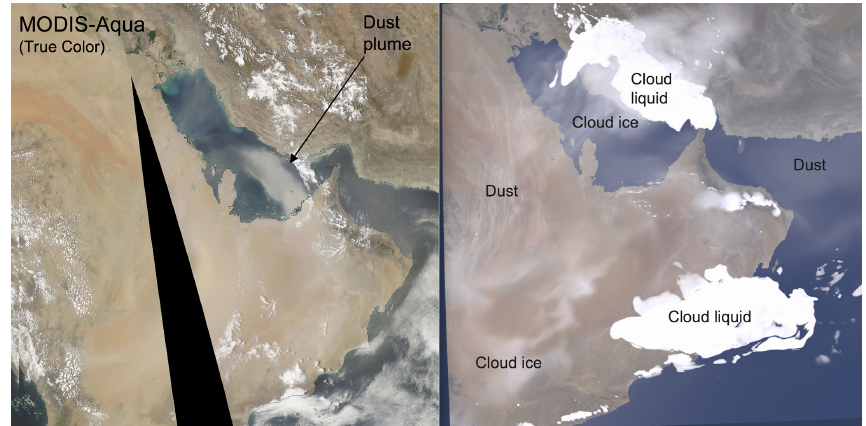
Figure 13. MODIS-Aqua image (left) taken from passes at about 13:30 mean solar time over the Arabian Peninsula compared with SWIm visualization of a RAMS model forecast (right) from 10:00UTC. Areas having predominantly dust, cloud liquid, and cloud ice are annotated in the